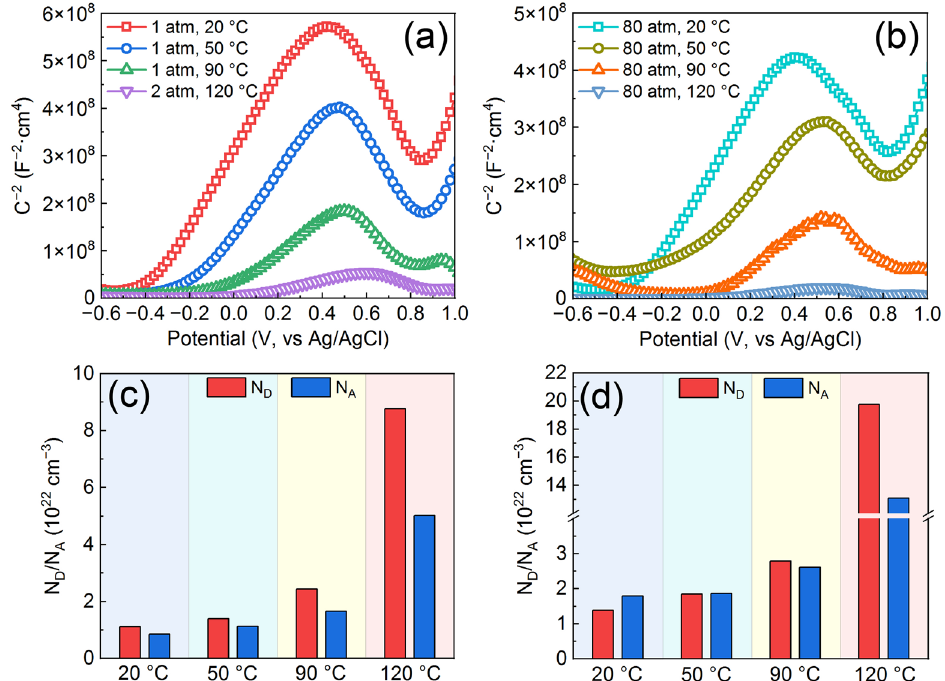
Figure 5. Mott-Schottky plots for the passive films formed on the AMCs: ( a ) at normal pressure, ( b ) at high pressure; Carrier concentration of the passive films formed on the AMCs: ( c ) at normal pressure, ( d ) at high pressure.